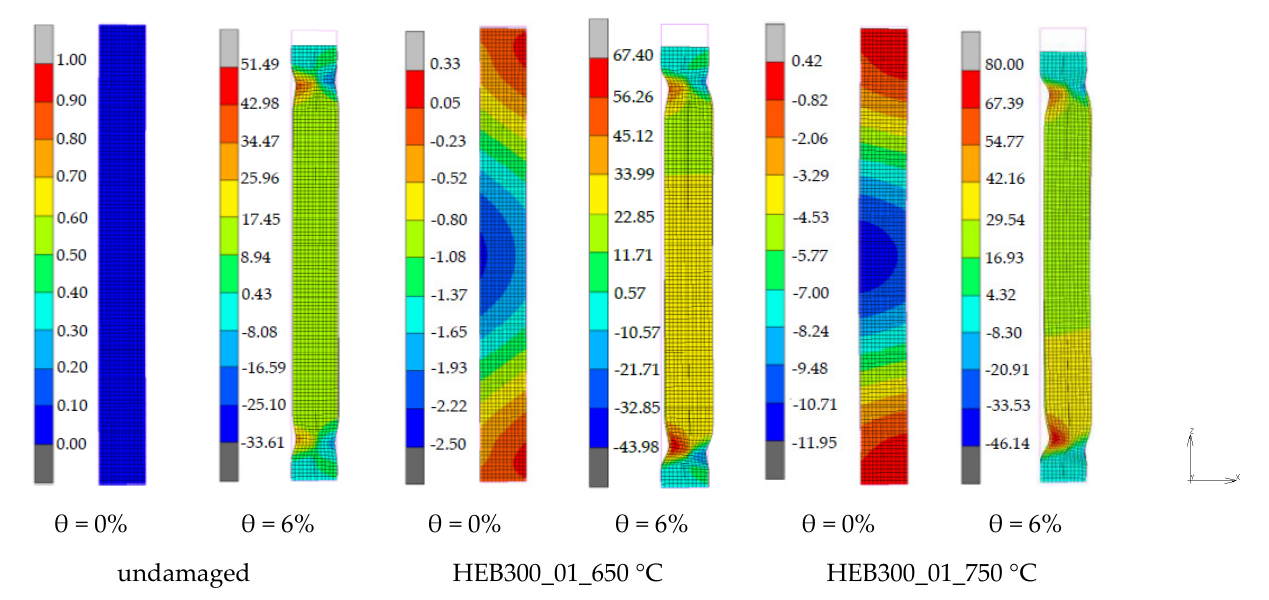
Figure 13. Deformed shape of the HEB300_01 columns at the begging of cyclic loading ( θ = 0%) and for the θ = 6% chord rotation.